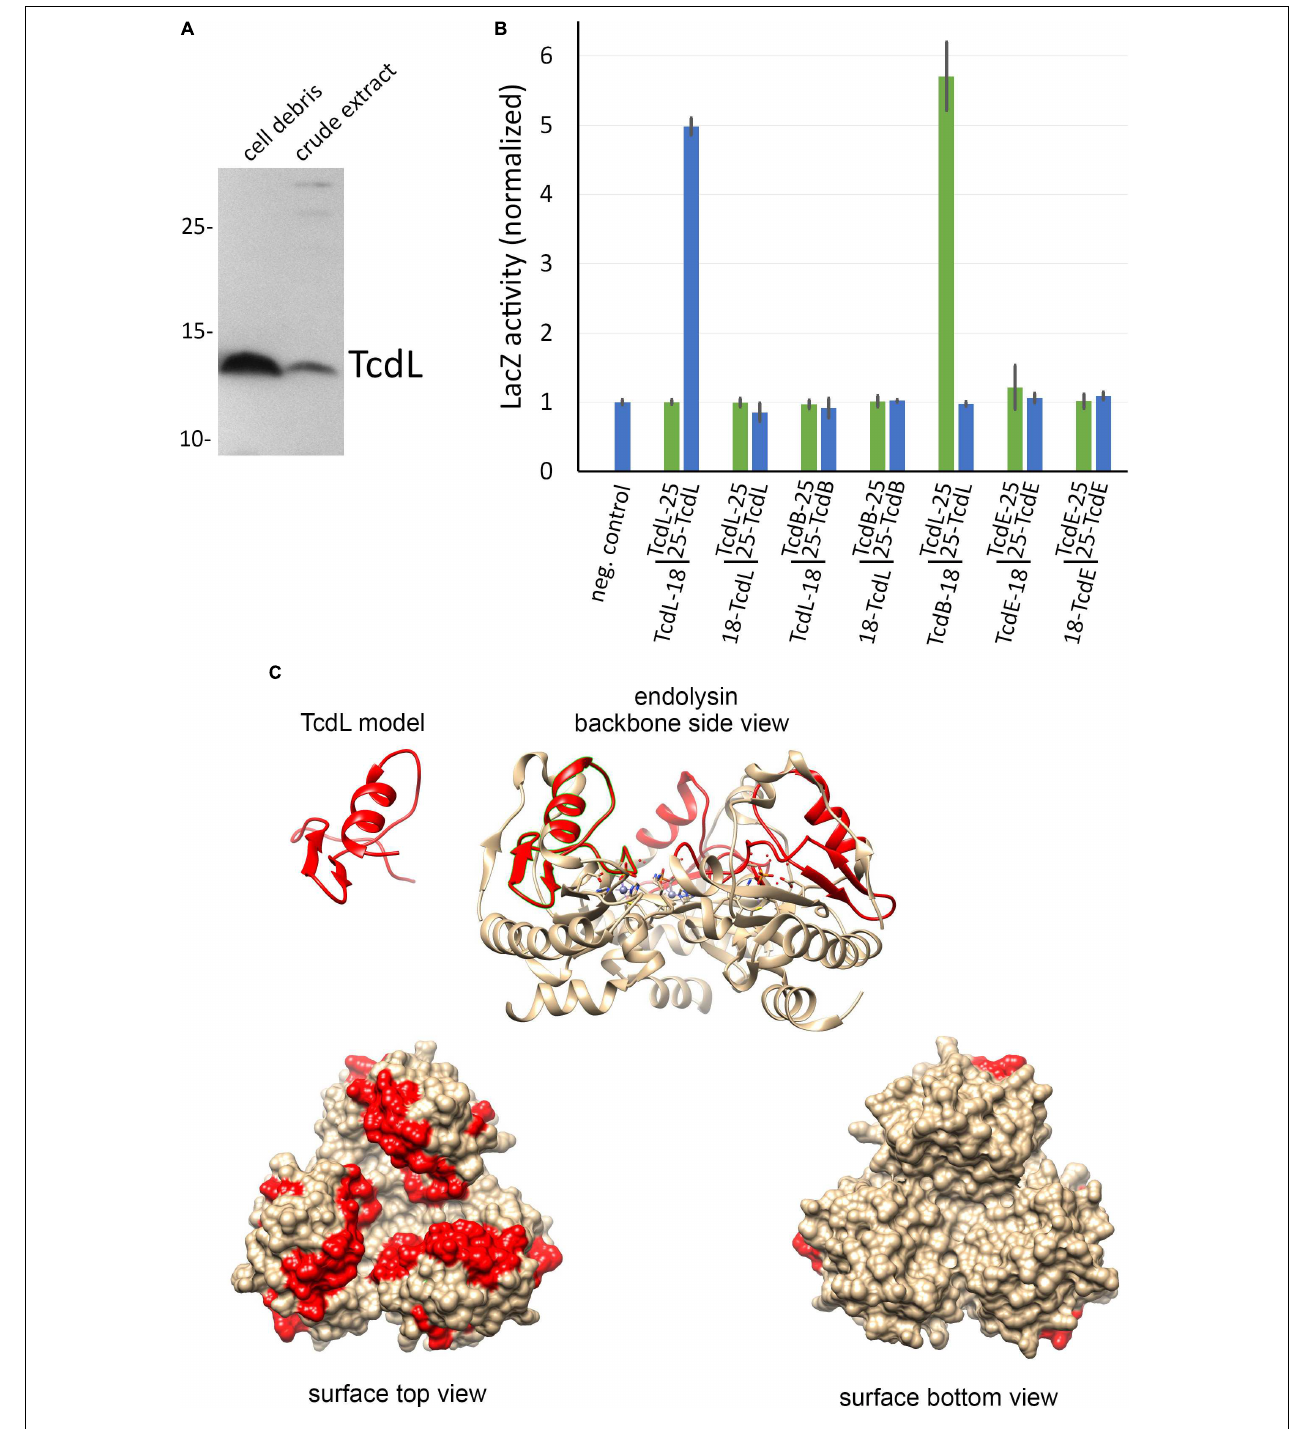
FIGURE 5 | Analyses of TcdL. (A) SDS–PAGE/Western blot detection of recombinantly produced Strep-tagged TcdL in cell debris and crude extract from the E. coli strain ER2566 pBW- tcdL -strep using Strep-Tactin alkaline phosphatase conjugate and NBT/BCIP. (B) Bacterial-2-hybrid analysis of TcdL, TcdB, and TcdE interactions, using LacZ activity assays. Data were normalized to the negative control values. Adenylate cyclase domains T18 or T25 were fused N-terminally or C-terminally to the proteins as indicated below the diagram. Note that the N-terminal TcdL-fusion to T18 (= TcdL-18) interacted with the C-terminal TcdL-fusion to T25 (= 25-TcdL), and the N-terminal TcdB-fusion to T18 (= TcdB-18) interacted with the N-terminal TcdL-fusion to T25 (= TcdL-25). (C) Homology-modeled TcdL structure and the corresponding region in the trimeric prophage endolysin (PDB 1YB0). Homology modeling was done using Swiss-Model (Waterhouse et al., 2018), and the images were created using CHIMERA (Pettersen et al.,